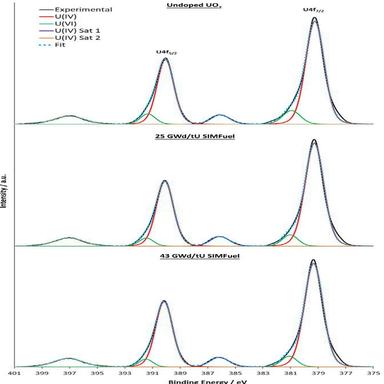
High resolution XPS scans of the U4f region for the undoped UO2, 25 GWd/tU SIMFuel and 43 GWd/tU SIMFuel samples.